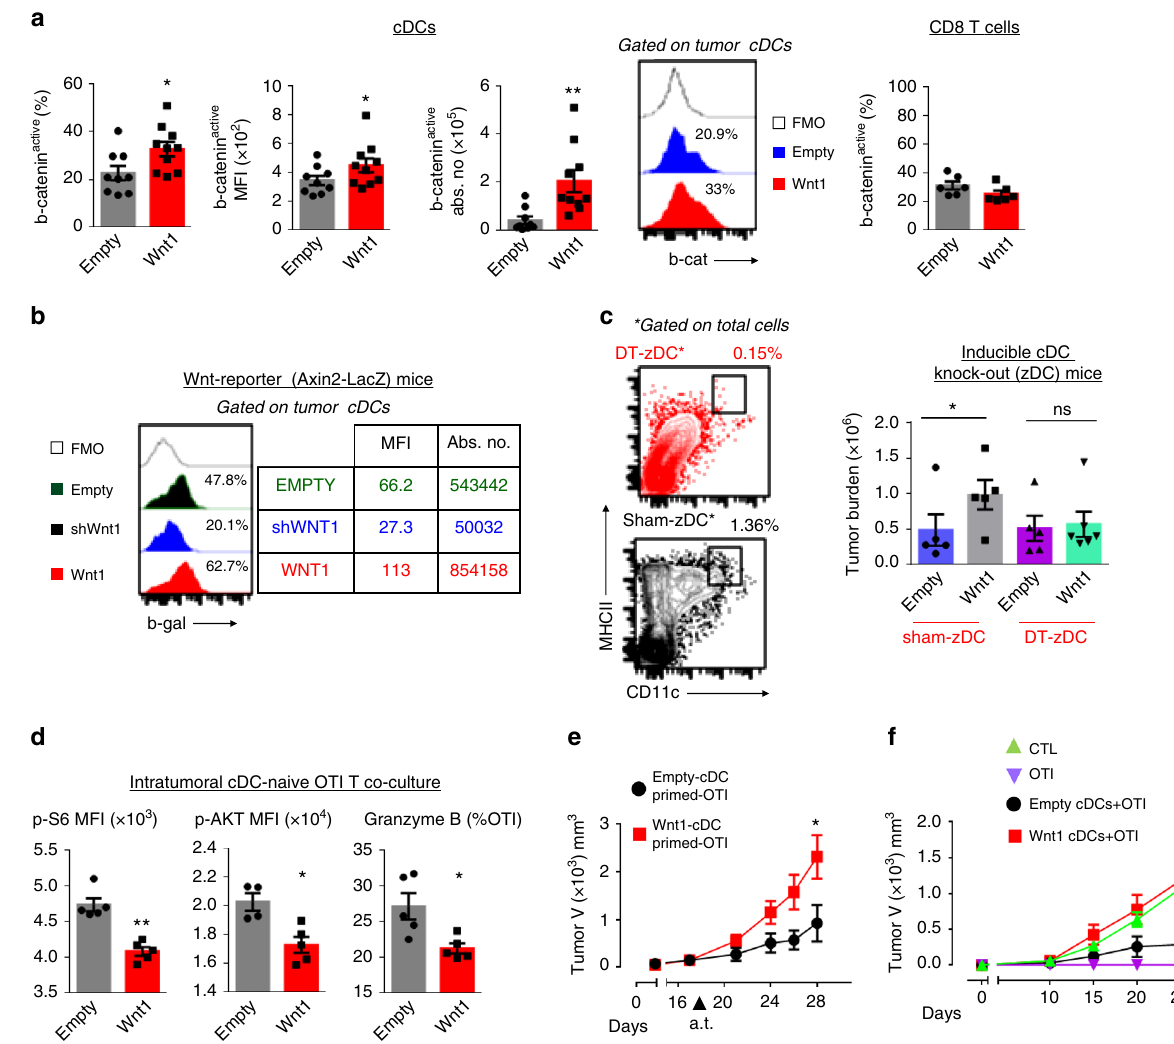
Fig. 4 Wnt1 overexpressing tumors depend on DC signaling to evade T cells. Intratumoral cDCs were analyzed by FACS. a Percentages of b-catenin active cDCs, MFI of b-catenin in cDCs, absolute number of b-catenin active cDCs and representative histogram plots (Left). Percentages of b-catenin active CD8 + T cells (right). b Histograms showing b-galactosidase expression (%) by intratumoral cDCs of Axin2LacZ Wnt-reporter mice (Left) MFIs and absolute numbers of galactosidase expressing cells (right). c FACS plots depicting the depletion ef fi ciency of intratumoral cDCs in zDC mice after DT injection (Left). Tumor burden (total absolute number of LLC cells) in sham vs. DT-treated (cDC-depleted) zDC mice (right). d Naive OTI T cells were co- cultured with puri fi ed cDCs from Wnt1-overexpressing vs. control OVA-LLC tumors. TCR pathway activation (p-S6 and p-AKT) and cytotoxic molecule expression (granzyme B) were measured by FACS. e OTI T cells that had been primed by intratumoral cDCs as in d were adoptively transferred to mice bearing established subcutaneous OVA-LLC tumors. Graph depicts tumor growth. f Healthy mice were co-adoptively transferred with naive OTI T cells and puri fi ed cDCs from Wnt1-overexpressing vs. control OVA-LLC tumors. After 5 days mice were transplanted with OVA-LLC tumors. Graph depicts tumor growth. a – f Cell numbers and pro fi les were assessed by FACS. Error bars represent mean with SEM. Data are representative or cumulative of at least two independent experiments with 4 – 9 mice per group. * p < 0.05; ** p < 0.01, Mann – Whitney. Source data are provided as a Source Data fi